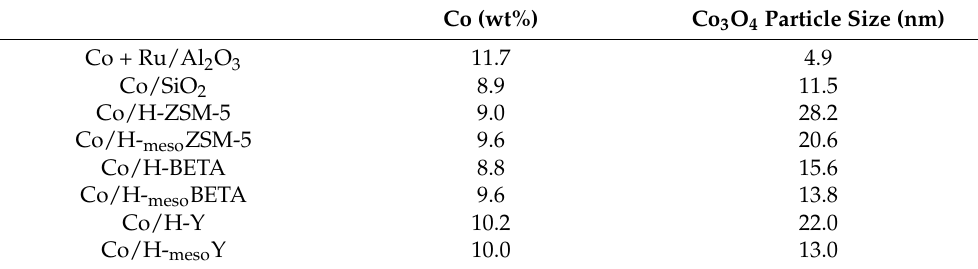
Table 2. All catalysts, including the cobalt loading and average particle size, determined by the Scherrer equation for the 2 θ = 43 ◦ diffraction.